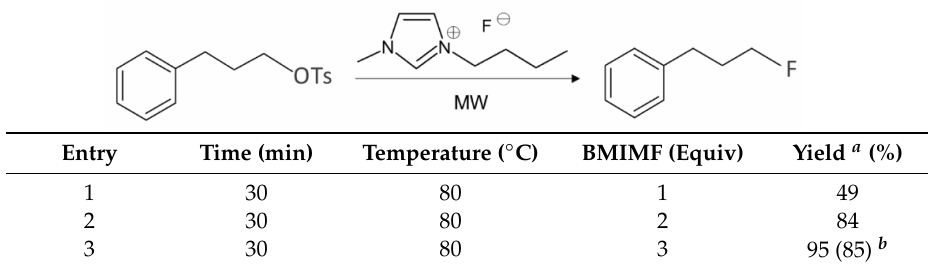
Table 2. Fluorination of 3-phenylpropyl p -toluenesulfonate with [bmim][F].